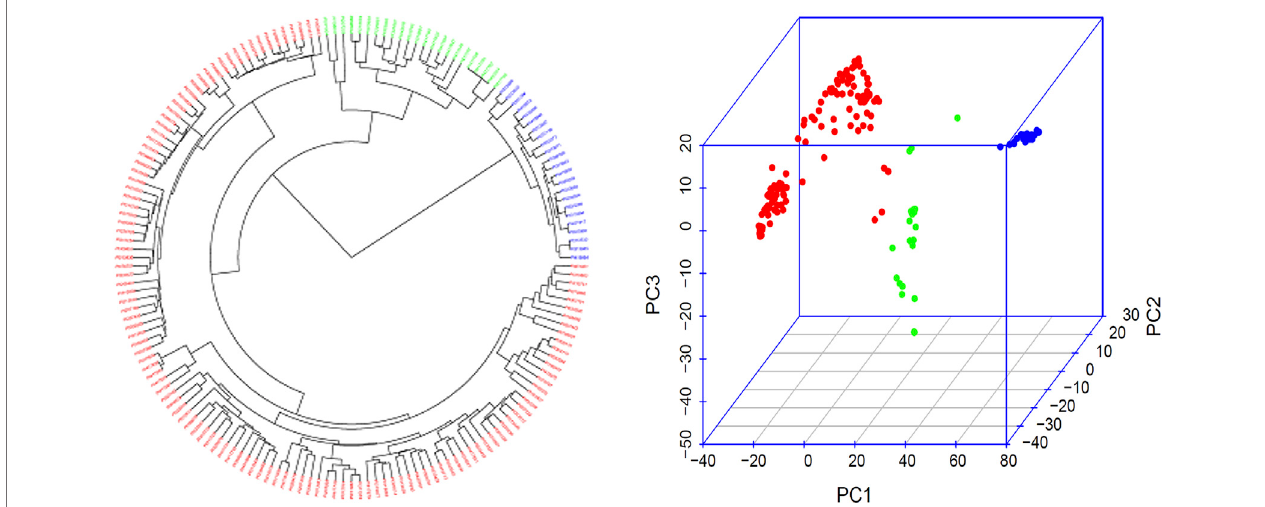
FIGURE2| Populationgenetic diversity analysisintheassociationpanelconsisted of168USDAcommonbean germplasm accessions.Phylogenetictreesdrawn by using theneighbor-joining(NJ)methodinthree subpopulation (left) and 3D graphical plotofthe principal component analysis(PCA) (right) drawn byusing GAPIT 3.A large phylogenetic tree of the three subpopulation for each of the 168 common bean accessions is shown in Supplementary Table S1